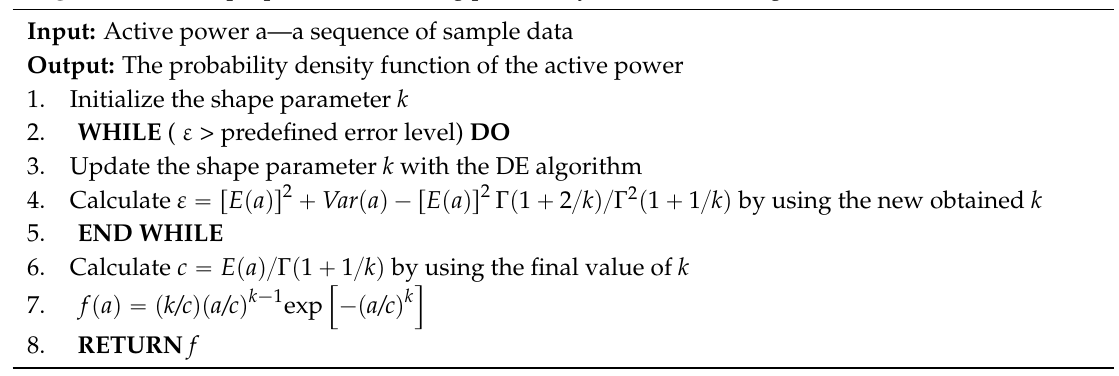
Algorithm 1 New proposed overloading probability measurement